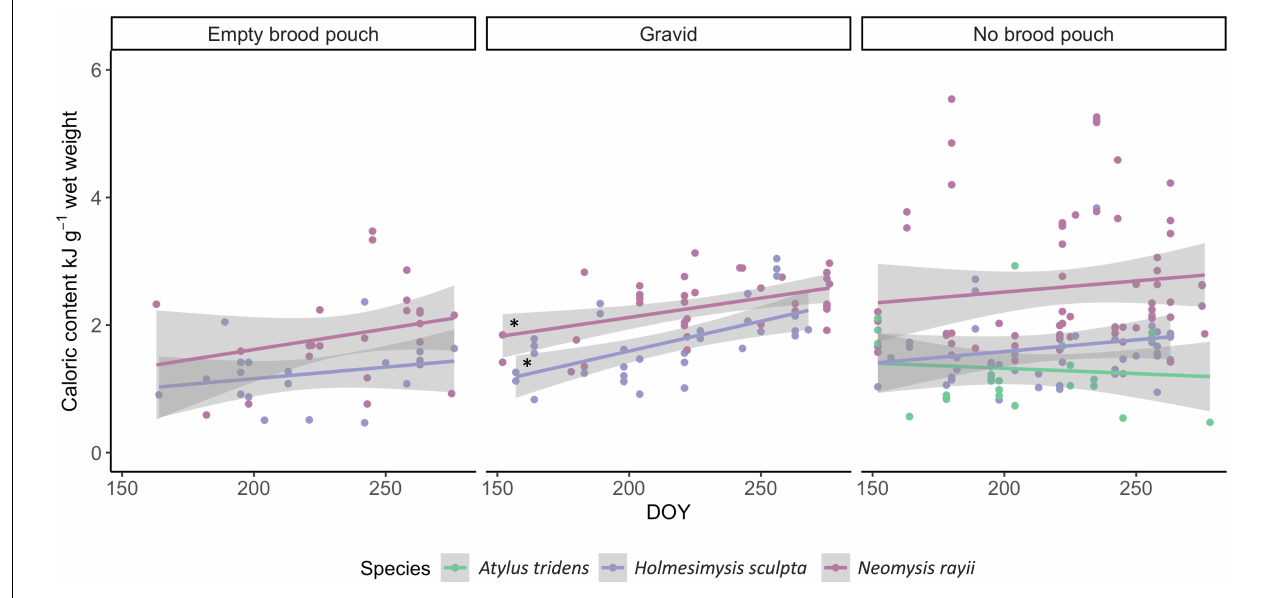
FIGURE 3 | Caloric content (kJ g - 1 wet weight) of different reproductive stages (empty brood pouch, gravid, and no brood pouch) as a function of day of year (DOY; ranging from June to October) for the mysids Holmesimysis sculpta and Neomysis rayii , and the amphipod Atylus tridens . A. tridens is only represented on one panel due to small sample size of this species for the empty brood pouch and gravid reproductive stages. Asterisks indicate significant regressions ( p < 0.02).